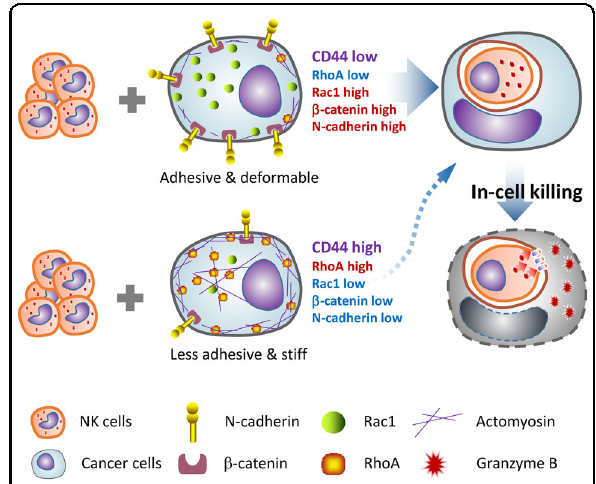
Fig. 8 Schematic demonstration of in-cell killing regulated by CD44. When CD44 is expressed at low level (upper panel), tumor cells express low level of RhoA and high level of Rac1, N-cadherin, and β -catenin, and are therefore more adhesive and deformable to internalize NK cells for CICs-mediated in-cell killing; whereas, when CD44 is expressed at high level (lower panel), leading to RhoA upregulation and the downregulation of Rac1, N-cadherin and β -catenin as well, tumor cells become less adhesive and stiffer which inhibits NK cell internalization and the subsequent in-cell